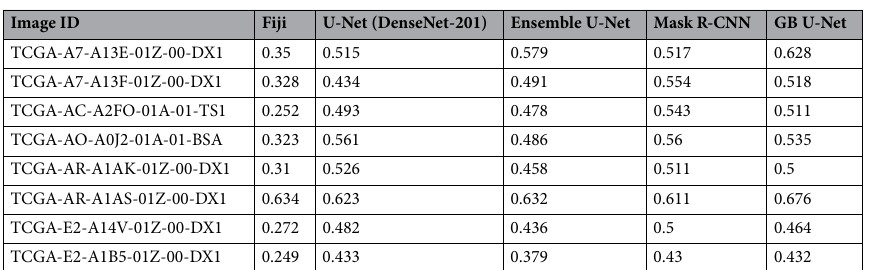
Figure 3. Nuclei annotations of the lowest and highest AJI images of the MoNuSeg dataset. Annotations pertaining to classical segmentation methods and the DCNN have been colour coded, such that green indicated true positive, red indicated false negative, and blue indicated false positive pixels. The original H&E images were curated by the TCGA. Ground truth annotations were released by Kumar et al. 16 , and additional annotations were released during the MoNuSeg challenge. Image